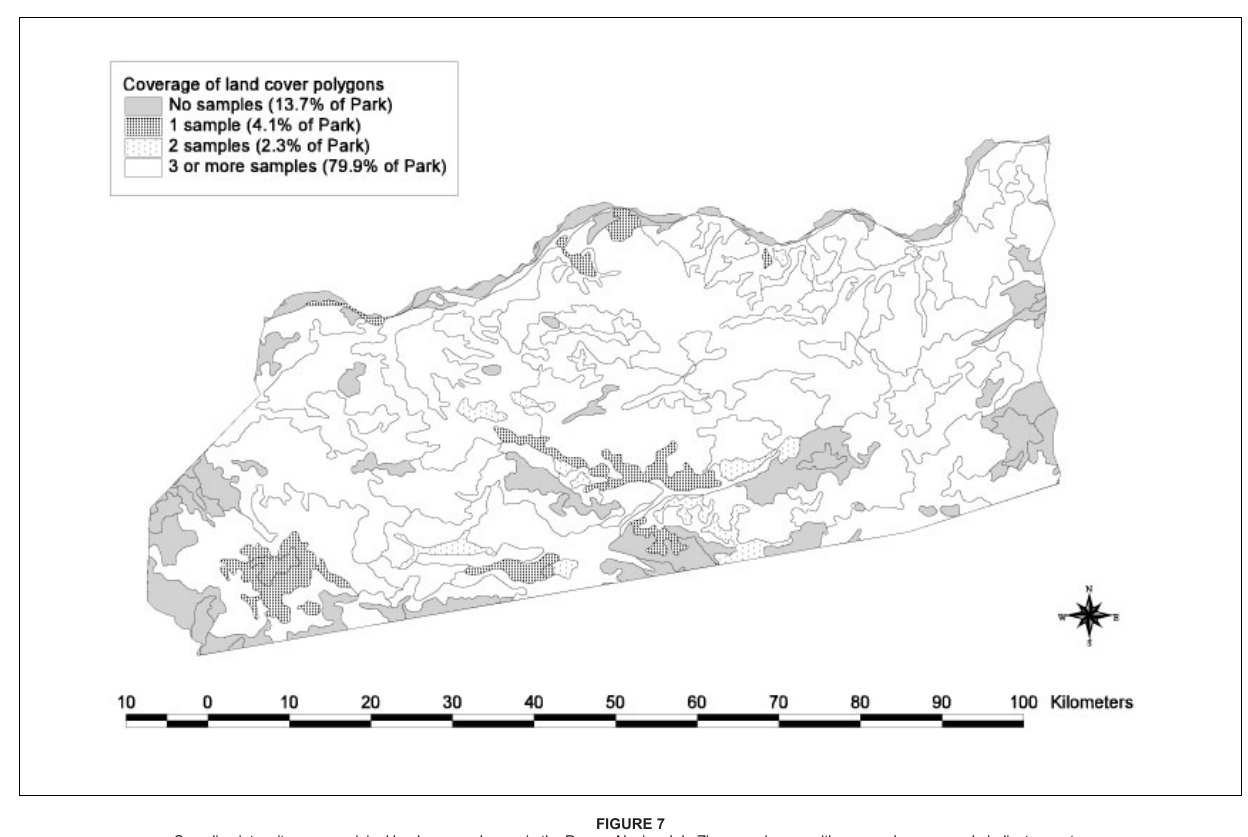
FIGURE 7 Sampling intensity across original land cover polygons in the Parque Nacional de Zinave; polygons with no or only one sample indicate greater uncertainty as to their correct landscape